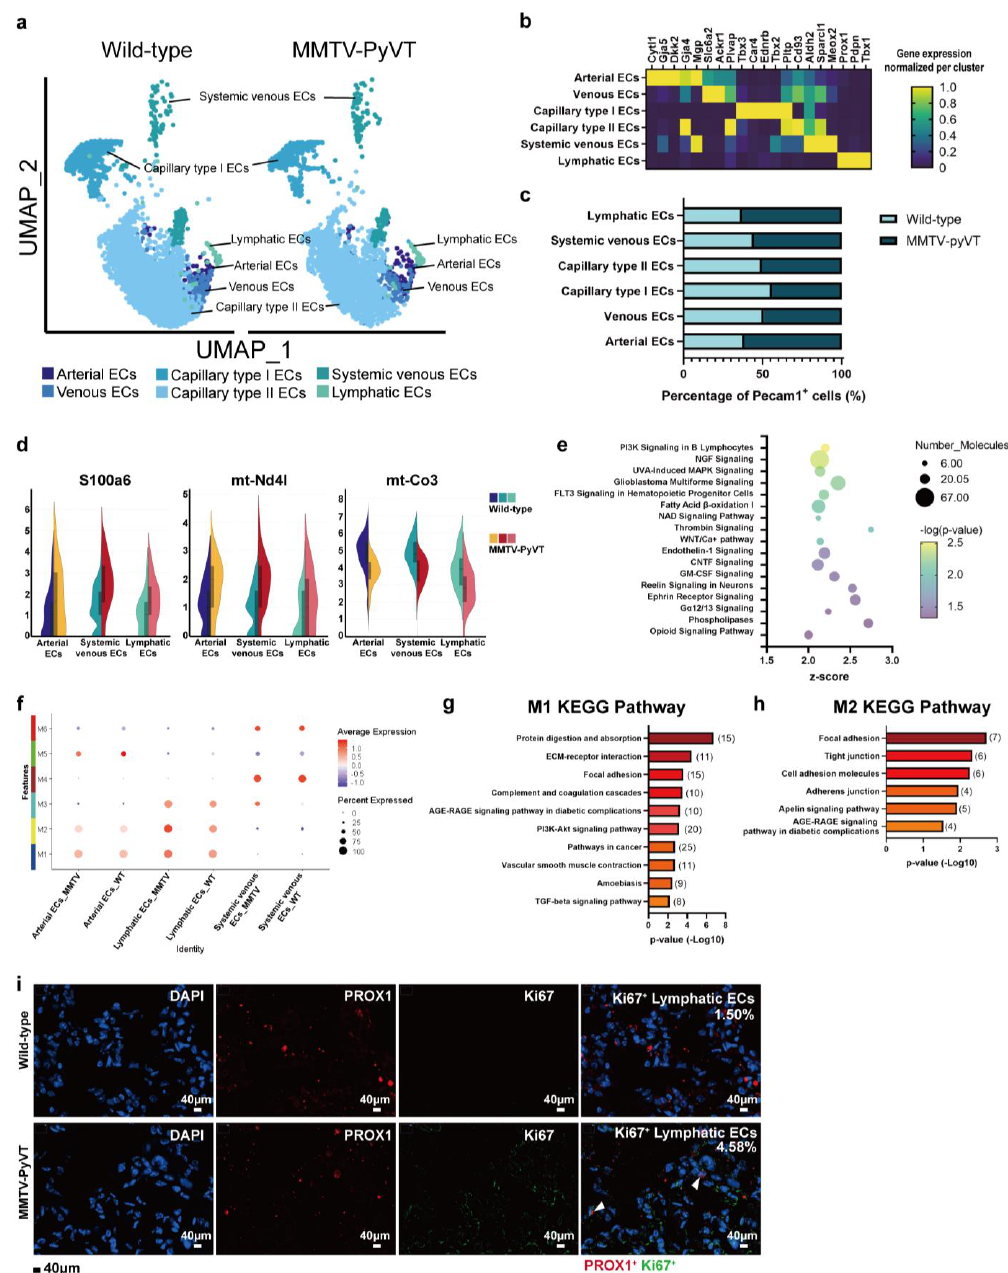
Figure 5. Detection of endothelial cell clusters in lungs of MMTV-PyVT mice. ( a ) Subpopulations of ECs in the lungs of mice. ( b ) Biomarkers for the subpopulations of ECs. ( c ) The cell numbers for each subpopulation of ECs. ( d ) Violin plots of differentially expressed genes in all EC subpopulations in wild-type and MMTV-PVT mice. ( e ) Pathway analysis of the transcriptome of lymphatic ECs in the lung. ( f ) WGCNA analysis of ECs in wild-type and MMTV-PyVT mice. The KEGG pathways of M1 ( g ) and M2 ( h ) modules of WGCNA. ( i ) Proliferative lymphatic ECs were found in the lungs of MMTV-PyVT mice. Tissue samples of the lungs of wild-type and MMTV-PyVT mice were collected and stained by CODEX Multiplexed Tissue Staining . Proliferative lymphatic ECs (PROX1 + (red) Ki67 + (green)) were indicated by white arrow. The percentage of proliferative lymphatic ECs were indicated as a percentage of total CD31 + cells. Scale bars, 40 µ